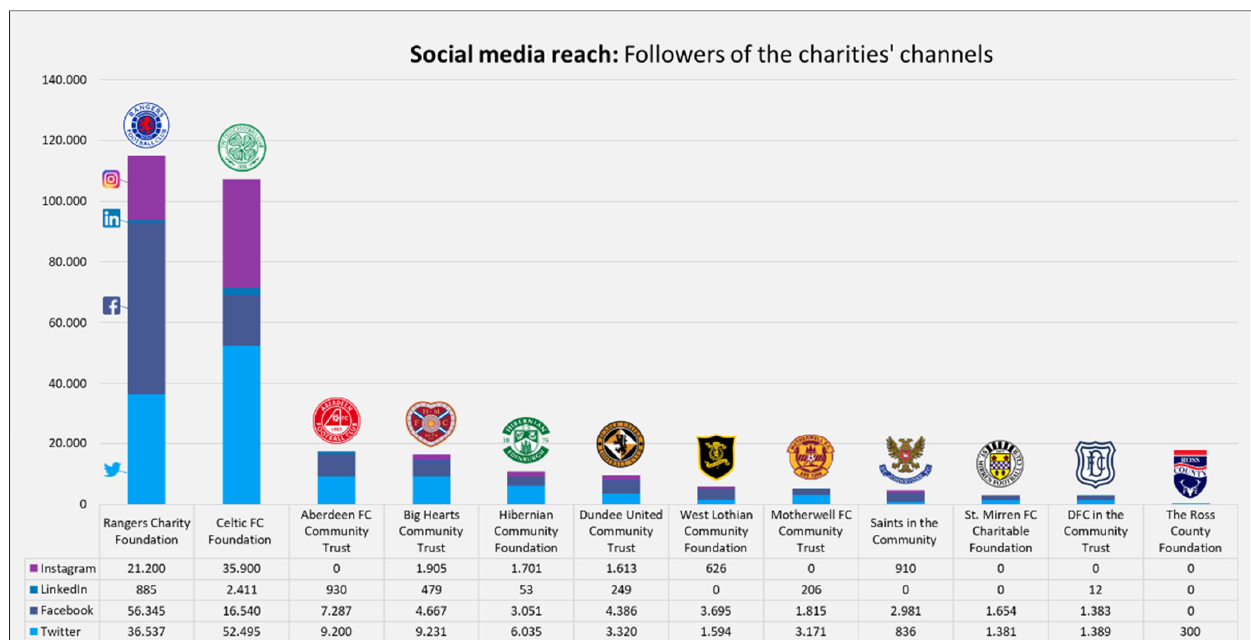
Figure 4. Outreach of the club charities’ digital platforms (as of 25 November 2021).